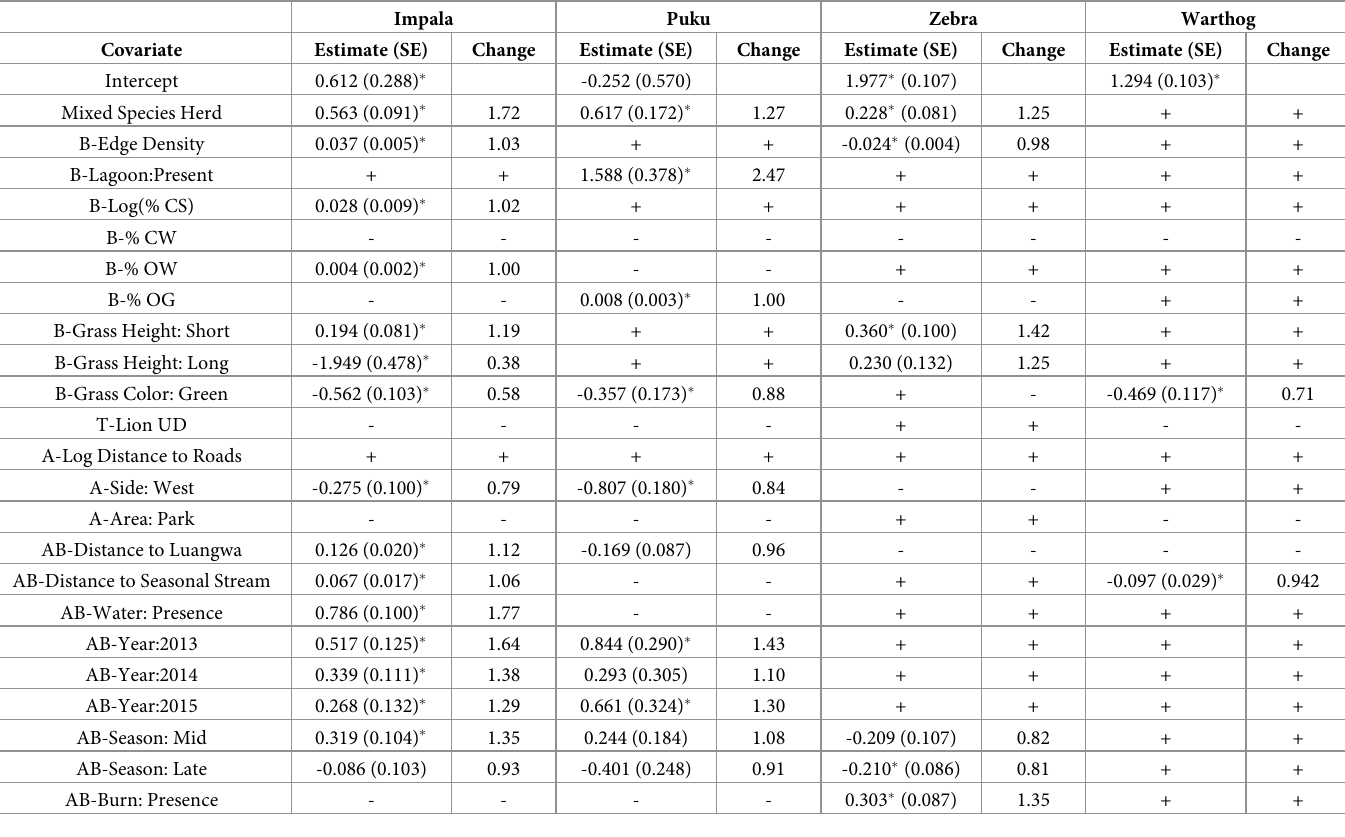
Table 5. Log-link coefficient estimates and standard errors from final herd size models. Change values are the multiplicative changes of group size based on the associ- ated coefficient estimate, derived using the predict() function. Covariates not included in the final models are indicated as either dropped during model refinement (+) or excluded from model refinement due to high correlation or imbalanced sampling